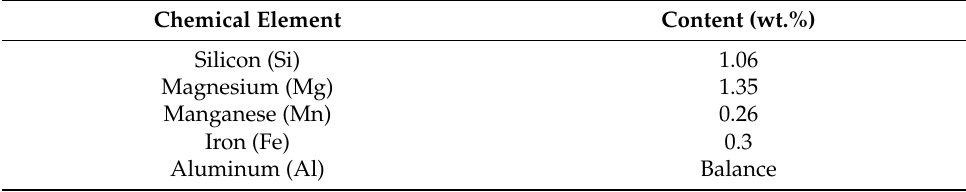
Table 1. Element composition of the alloy AW-6082 T6 obtained by EDS